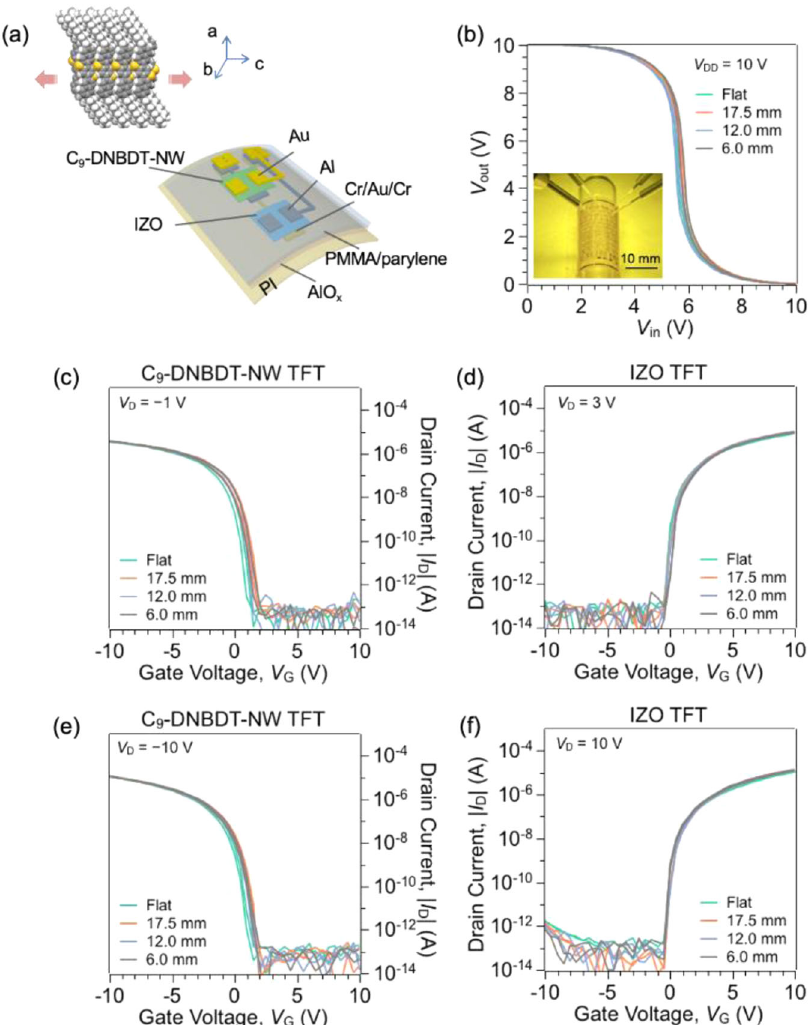
Fig. 5 Electrical performance of a hybrid complementary inverter under bending stress. a Schematic illustration of a device under bending stress. b VTCs of the inverter when fl at and bent to tensile radii of 17.5, 12.0, and 6 mm. The inset shows the measurement setup with a bending radius of 6 mm. Transfer curves of TFTs based on ( c and d ) C 9 -DNBDT-NW ( W / L = 100 μ m/19 μ m) and ( e and f ) IZO ( W / L = 50 μ m/24 μ m) in the linear and saturation regions under different bending stresses.